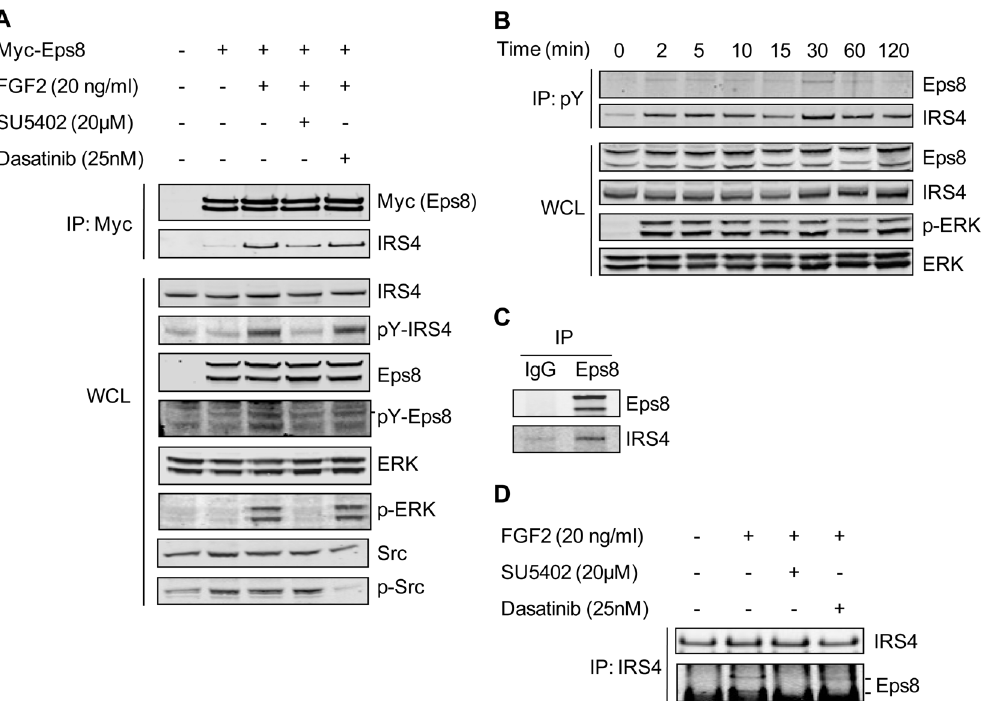
Figure 6. Eps8 and IRS4 interact in an FGF2 dependent manner that correlates with an increase in their tyrosine phosphorylation. A) HEK293T cells transfected with Myc-Eps8 were stimulated with 20 ng/ml FGF2 for 15 min either following 30 min pretreatment with SU5402 or dasatinib or in the absence of inhibitors. Anti-Myc immunoprecipitation and whole cell lysate samples were analysed by western blotting. B) HEK293T cells were stimulated with 20 ng/ml FGF2 for different lengths of time and tyrosine phosphorylated proteins were immunoprecipitated. Anti-pY immunoprecipitation and whole cell lysate samples were analysed by western blotting. C) HEK 293T cells were stimulated with 20 ng/ml FGF2 for 15 min and immnoprecipitations carried out using antibodies to either Eps8 or rabbit IgG. Resulting IP samples were analysed by western blotting. d) Following 30 min treatment with SU5402 or dasatinib and stimulation with 20 ng/ml FGF2 for a further 15 min, endogenous IRS4 was immunoprecipitated from HEK293T cells. Resulting IP samples were analysed by western